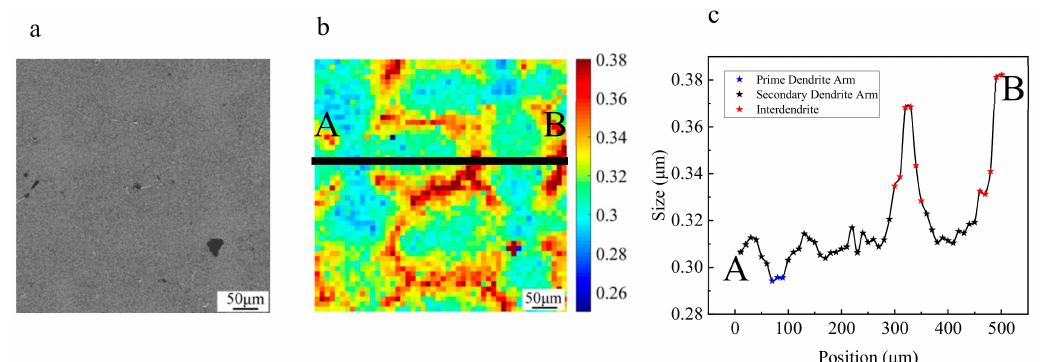
Figure 12. γ ’ phase size all-view scene distribution and special position line distribution. ( a ) Original SEM image of full field of view (0.5 mm × 0.5 mm); ( b ) γ ’ phase size distribution in the full field of view; ( c ) The line distribution of the γ ’ phase corresponds to the line AB in ( b ). The blue star is the size of the γ ’ phase at the primary dendrite arms, the black star is the size of the γ ’ phase at the secondary dendrite arms, and the red star is the size of the γ ’ phase between the dendrite